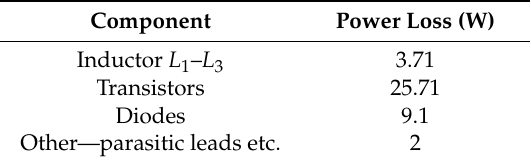
Table 2. Values of power losses on the individual components